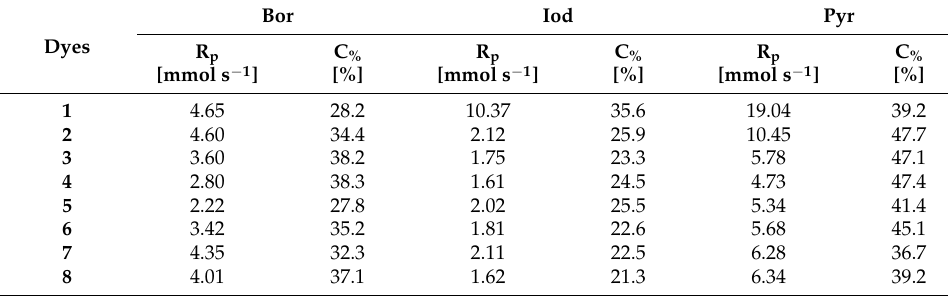
Table 2. The Kinetic Data of TMPTA